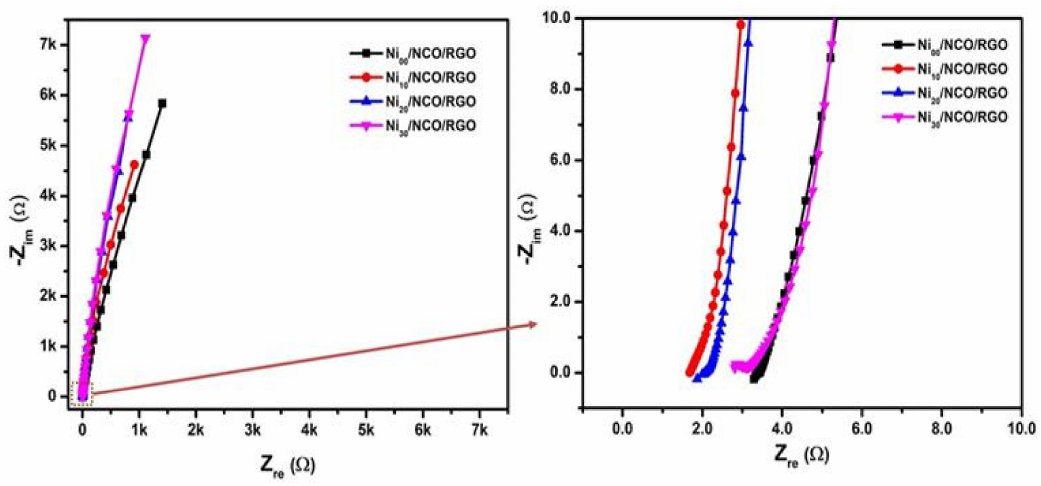
Figure 10. Electrochemical impedance spectroscopy (EIS) study (Nyquist plot) of various Ni/NCO/RGO electrodes at 100 kHz–0.01 Hz under 0.01